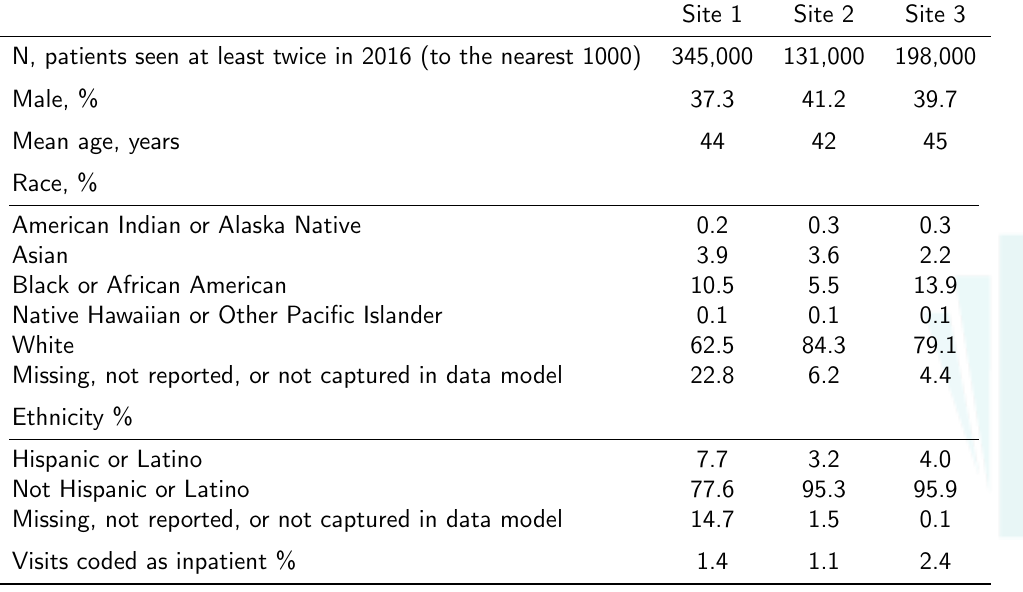
Table 1: Demographics of patients having at least two visits to each site in